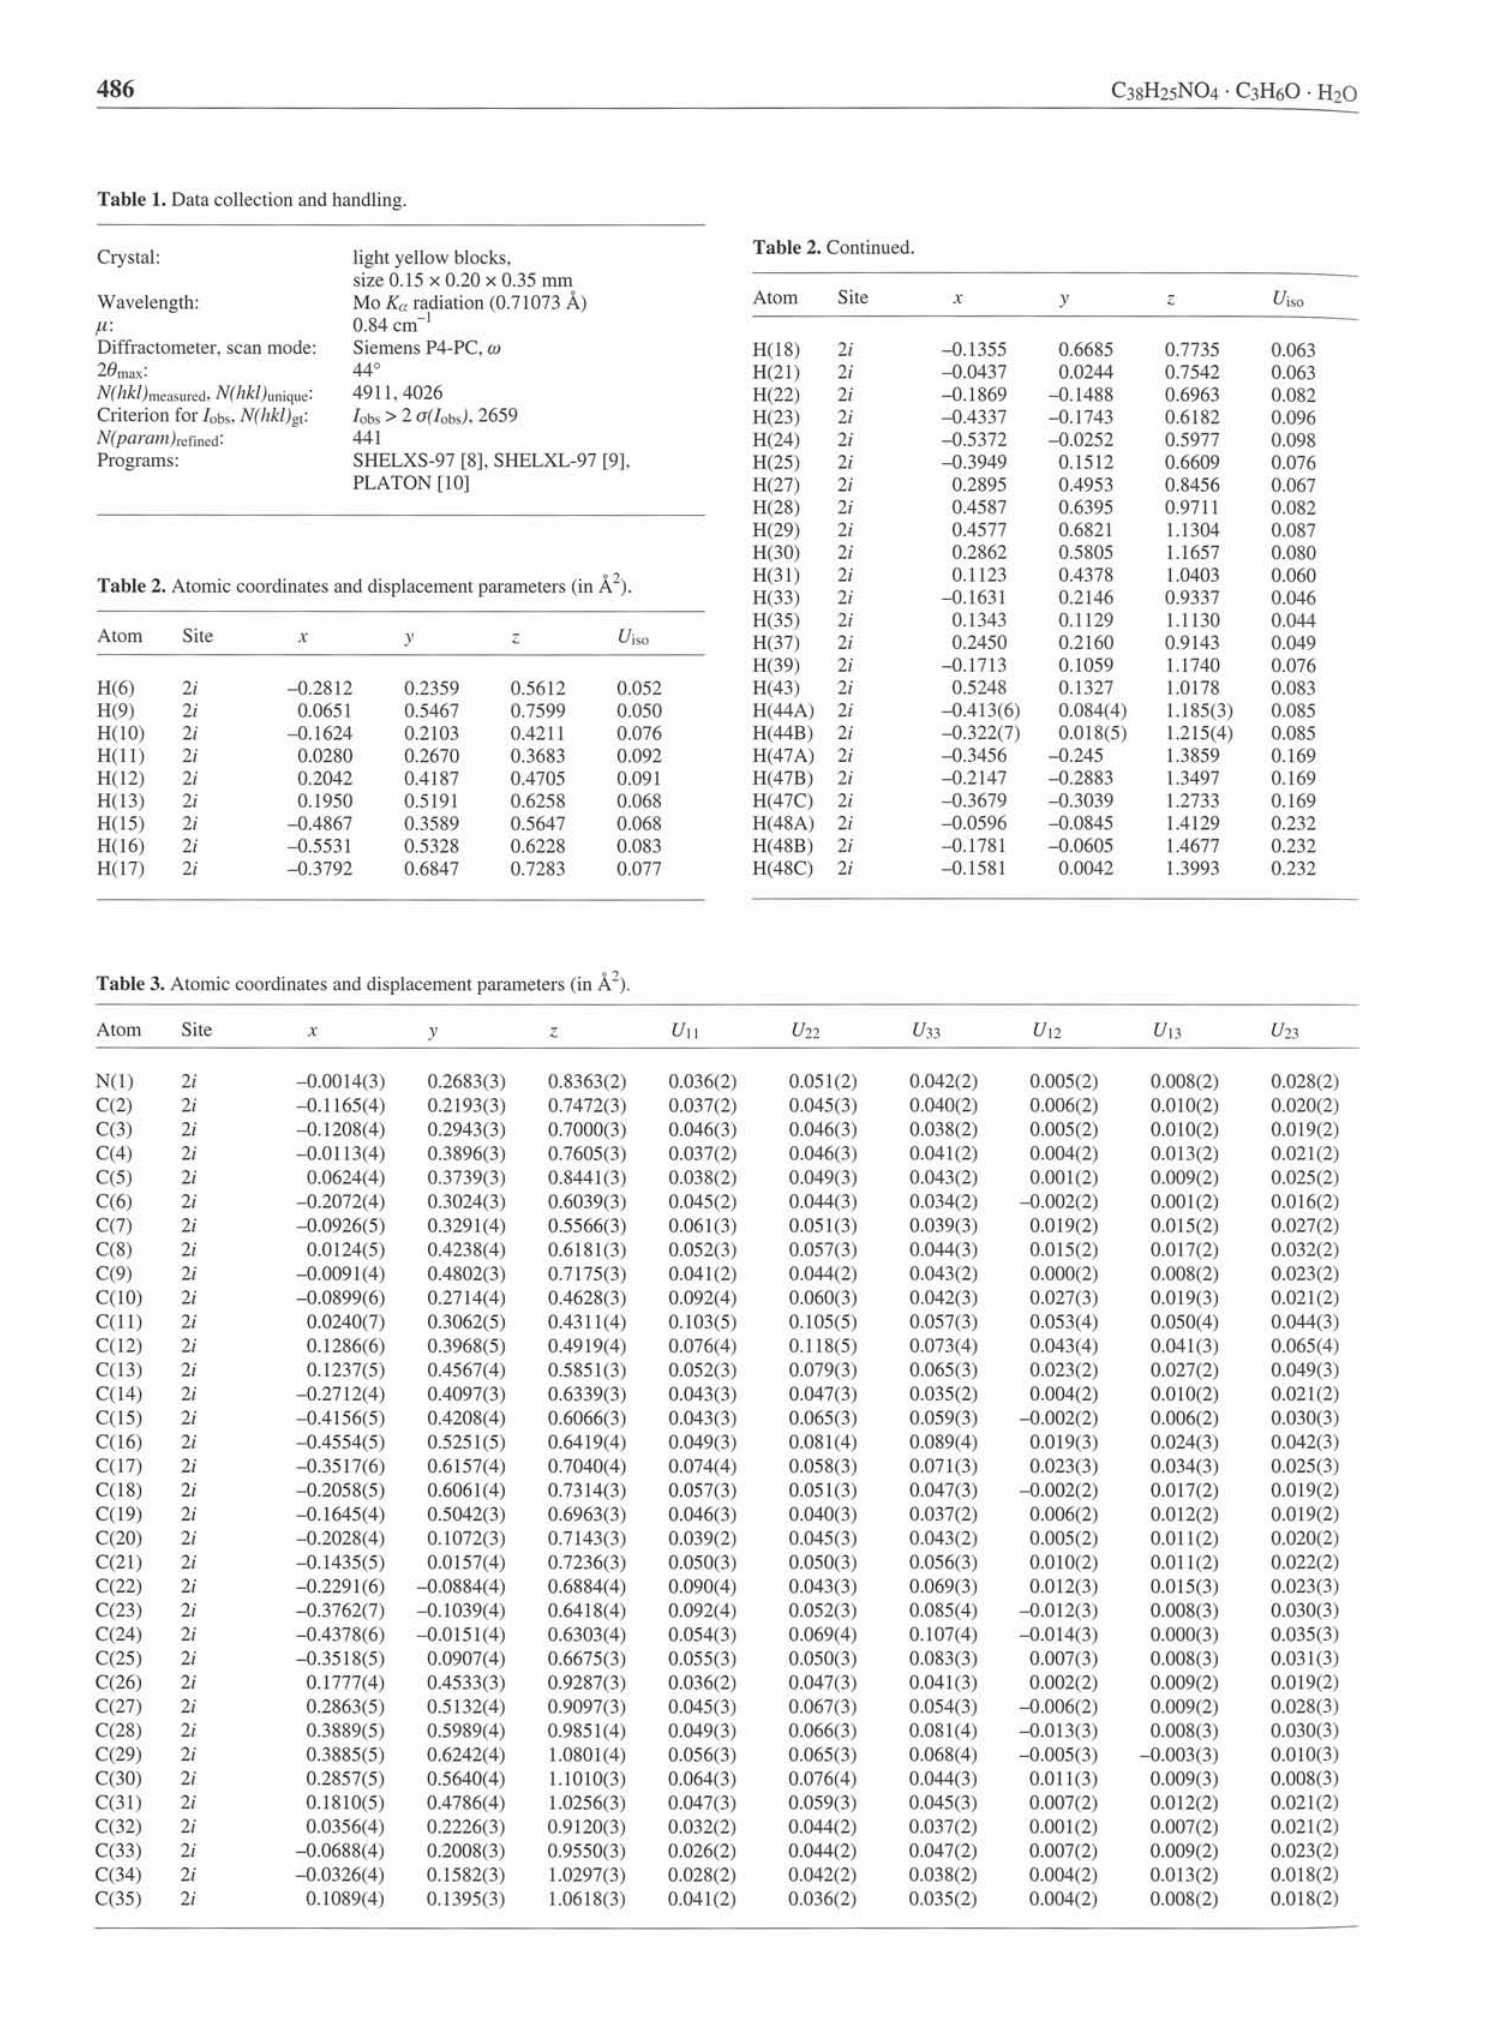
Table 1. Data collection and handling.